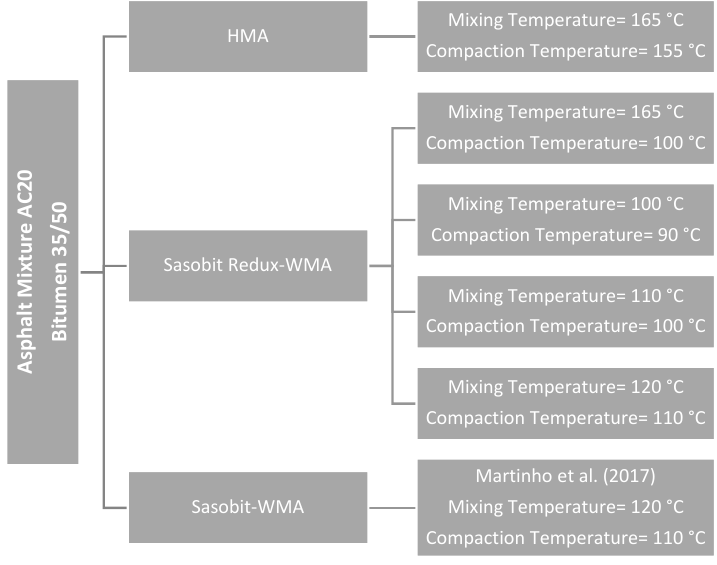
Figure 1. Asphalt mixtures and temperatures.